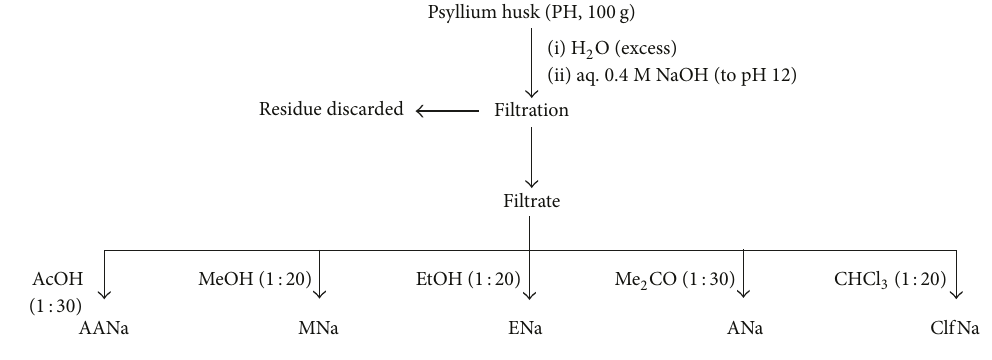
Figure 1: Separation of different fractions of husk gel.